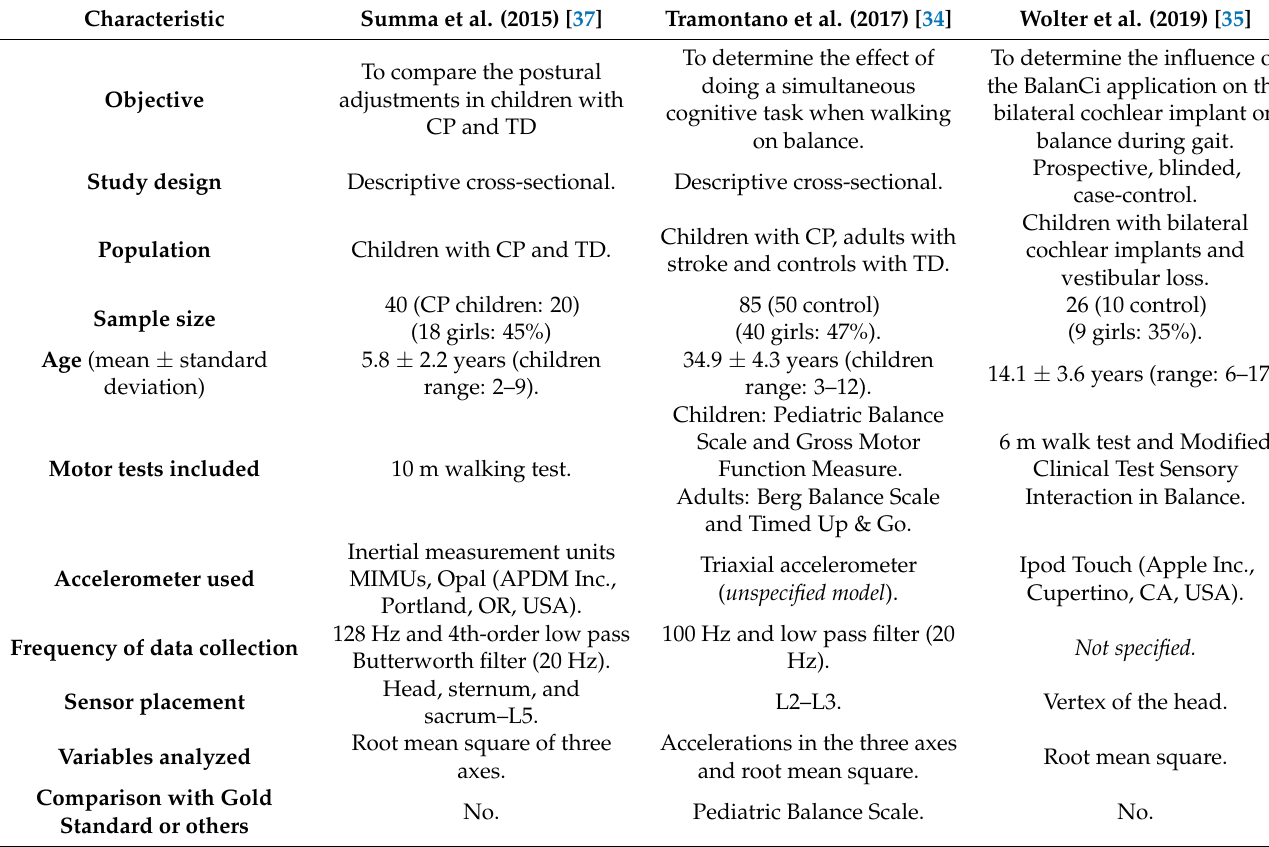
Table 6. Methodological characteristics of the articles